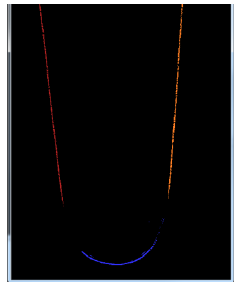
Fig. 6. Left line, right line and circle groups are illustrated in red, orange and blue colors,